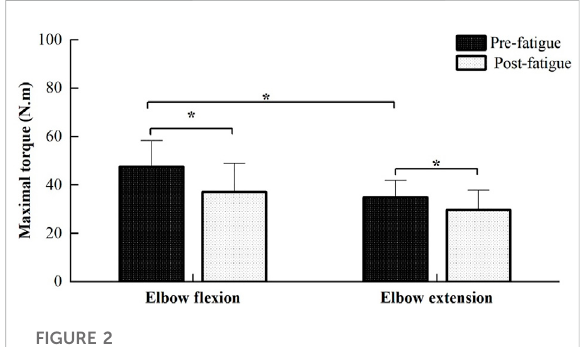
FIGURE 2 Comparisons of MVC torques of elbow fl exion and extension between the pre- and post-fatigue tests. The MVC torques of elbow fl exion were signi fi cantly higher than those of elbow extension for the pre-fatigue test ( p ≤ 0.001), while MVC torques in the post-fatigue test were found to be signi fi cantly lower than those ofthe pre-fatigue test for both elbow fl exion and extension ( p ≤